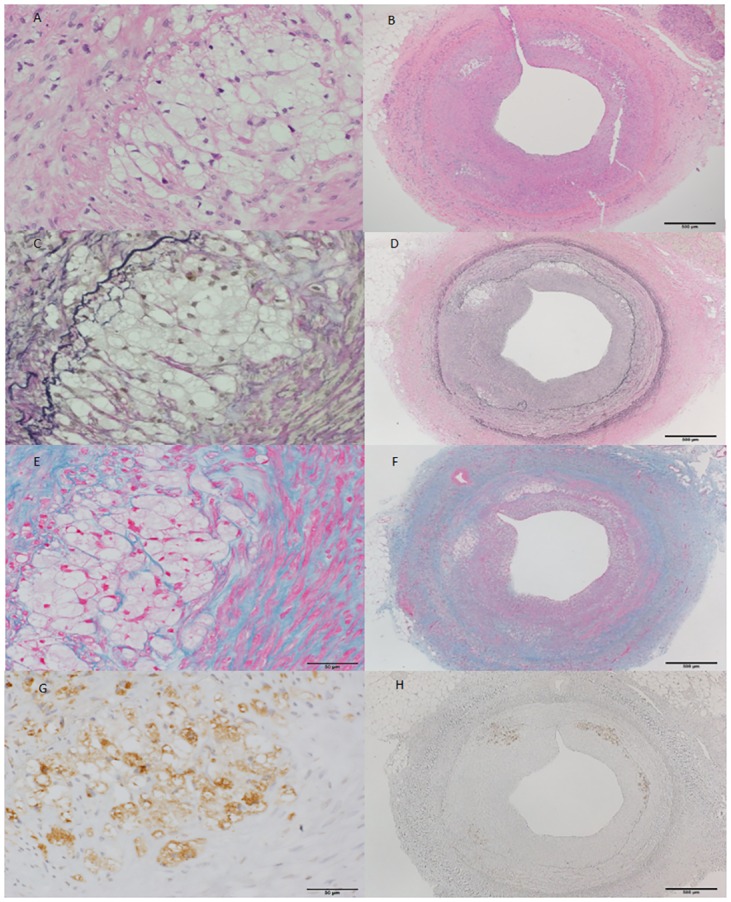
(A-H): Representative coronary section of LDLR-KO pig at four weeks after balloon injury.Intimal hyperplasia consists of accumulated lipid and dense macrophage infiltration. A and B, hematoxylin-eosin; C and D, Elastica van Gieson; D and E, Azan; G and H, cathepsin S immunohistochemical staining. Scale bar, 500 μm on the left panel and 50 μm on the right panel.